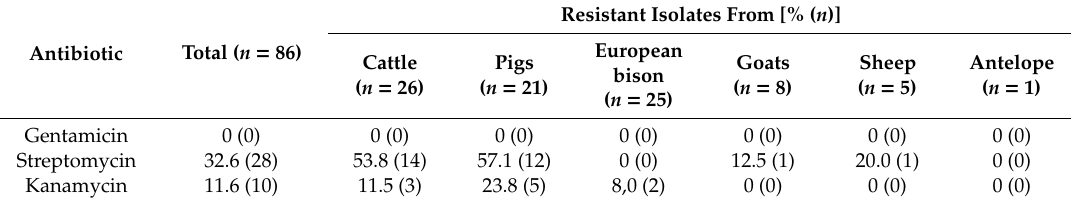
Resistant Isolates From [% ( n